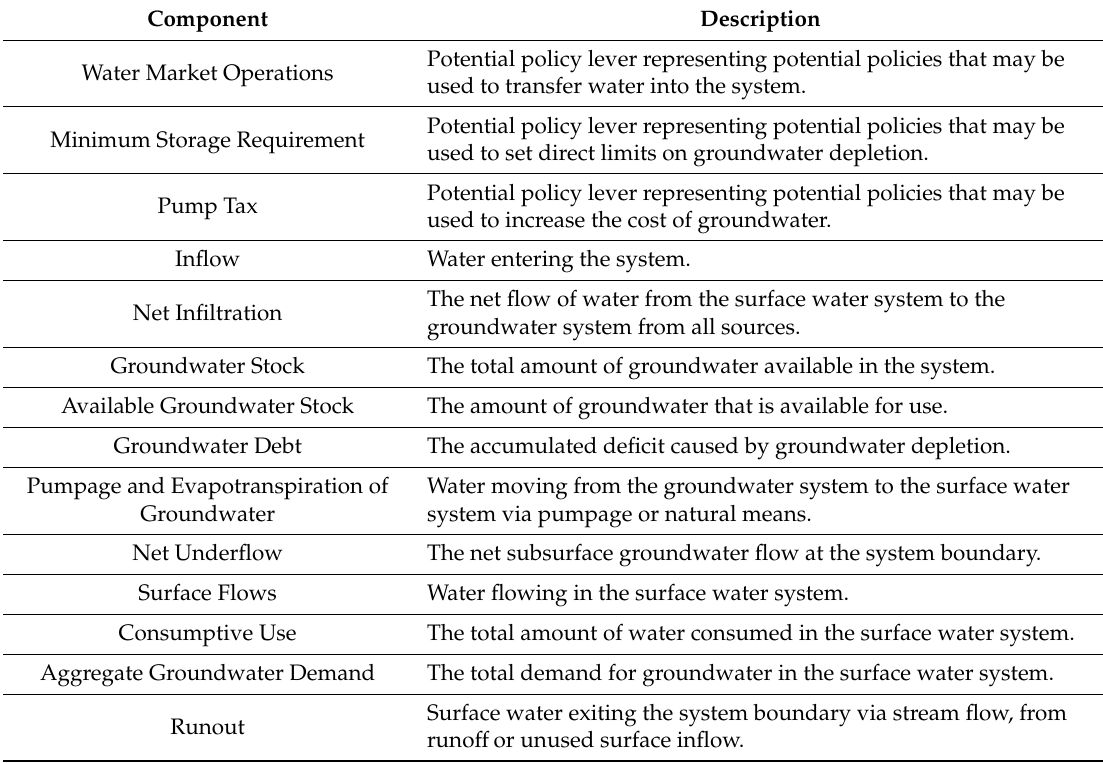
Table 1. General model system components and descriptions